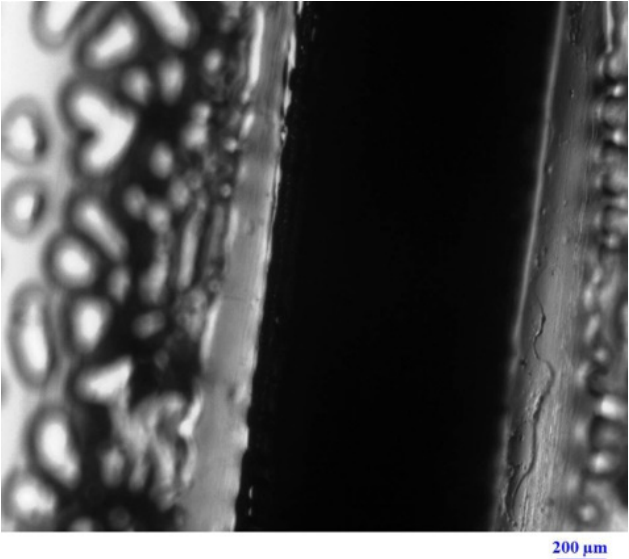
Figure 1. Photomicrographs from an optical microscopy of the cross-section of CP-loaded nanofibrous film (CP-F).